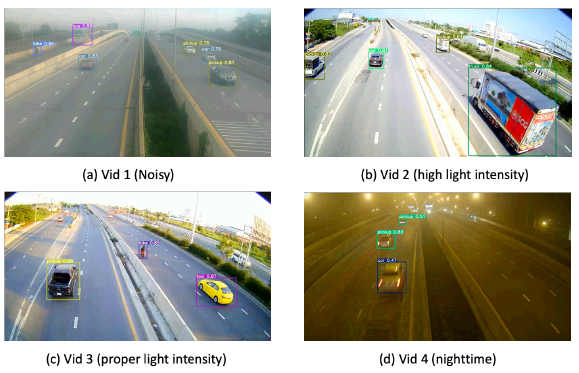
Figure 6: Sample of vehicle classification in